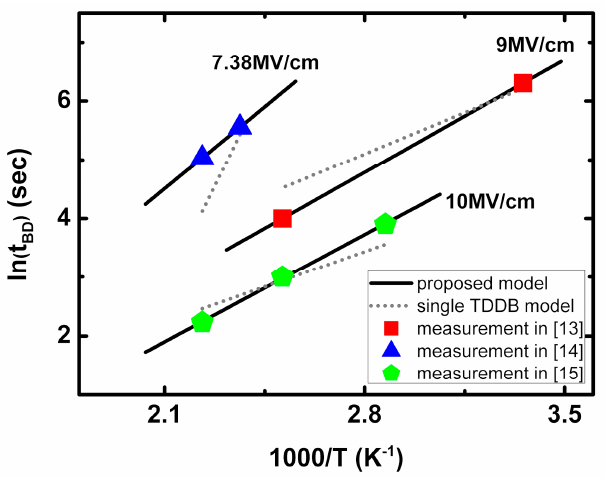
(cid:2868) refers to the maximum value of the traps, which can be generated by the TC mechanism, i.e.,